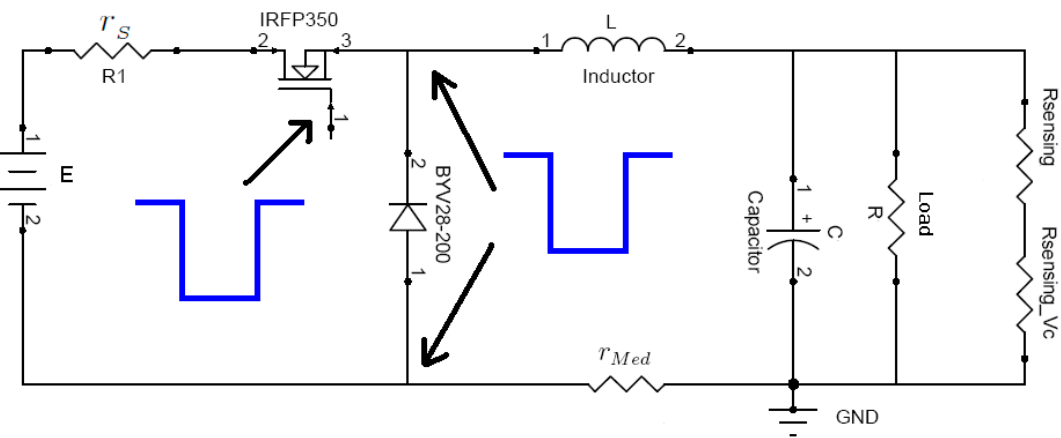
Figure 7. Electric circuit of the buck converter.